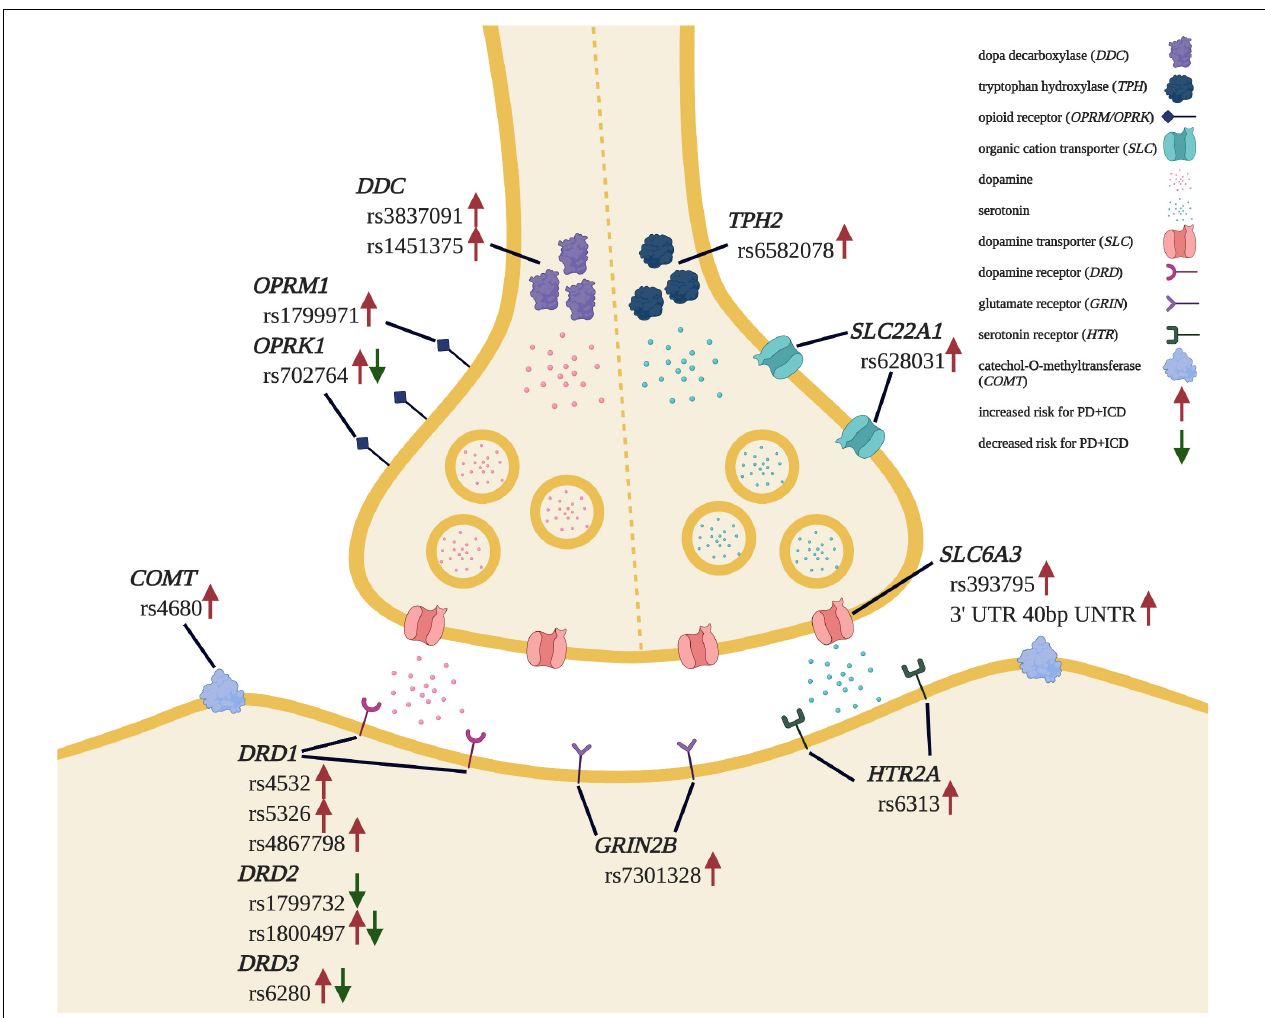
FIGURE 1 | Genetic landscape of PD + ICD risk. Genetic polymorphisms found to be associated with increased and/or decreased risk for ICD development in PD patients are indicated. Adapted from “Synaptic Cleft” by BioRender.com (2020). Retrieved from https://app.biorender.com/biorender-templates.